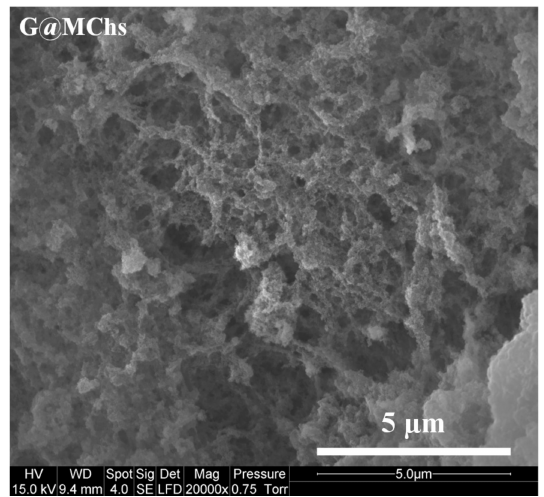
Figure 1. SEM micrograph of G@MChs.